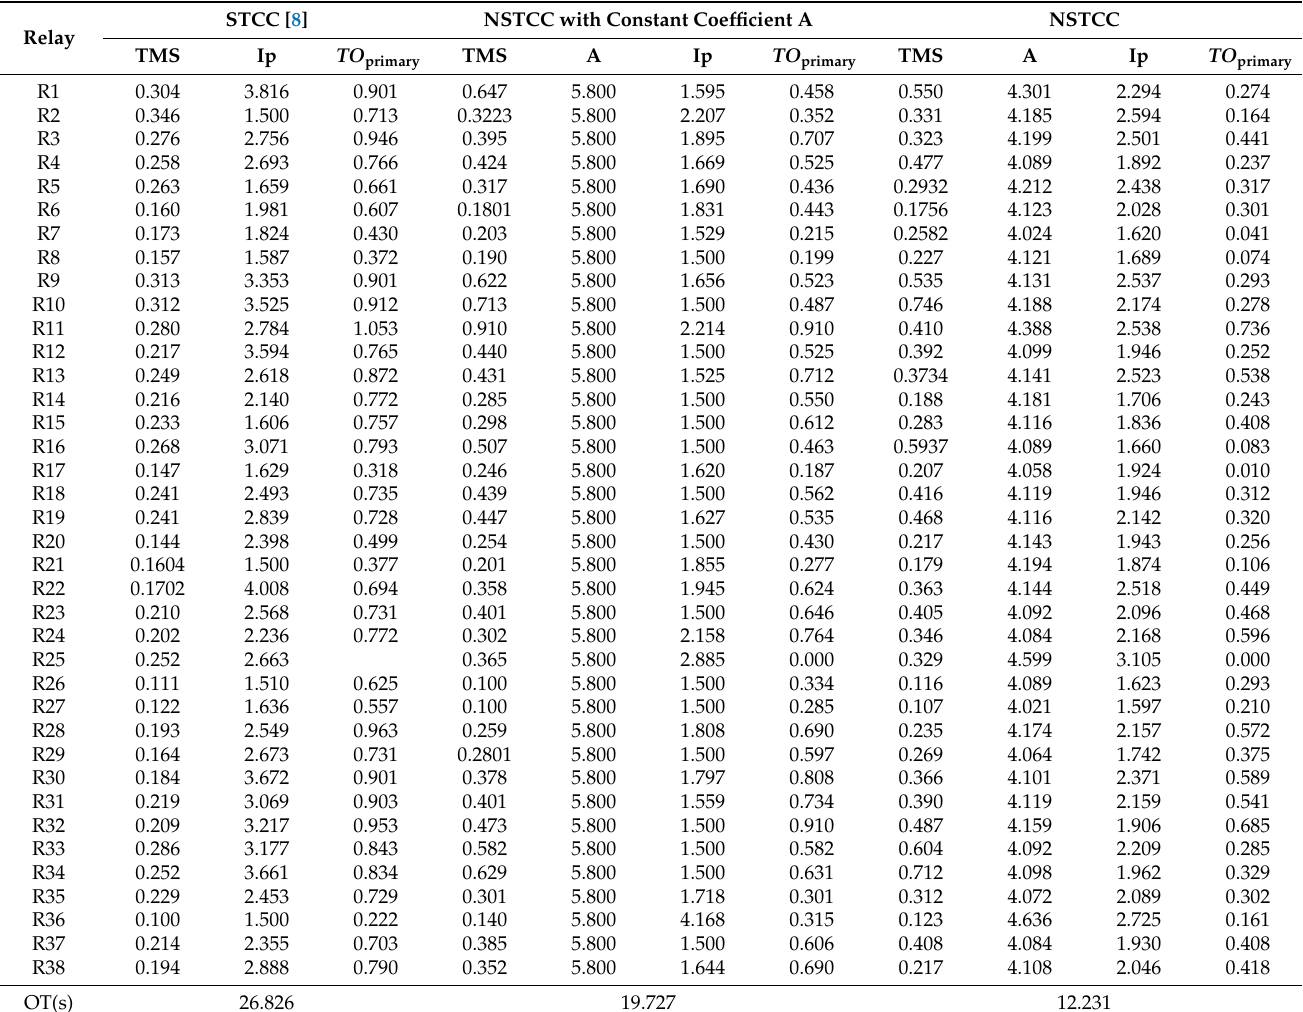
Table 12. Optimal TMS, Ip, and A for the Meshed 30-bus Test